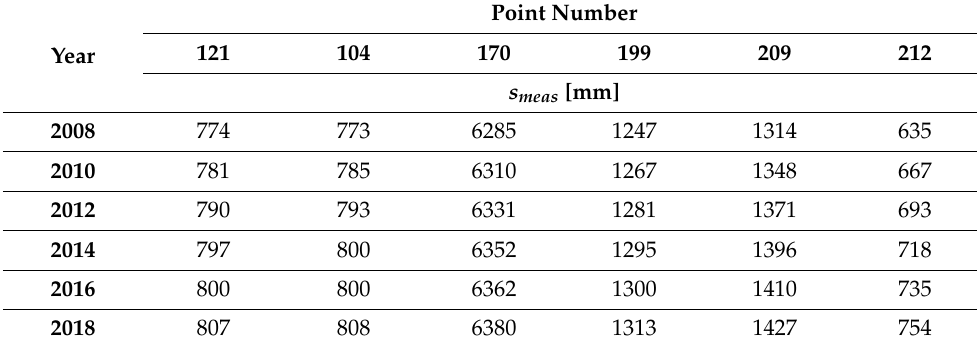
Table 1. Values of measured subsidence s meas of measuring points in two-year intervals until 2018.